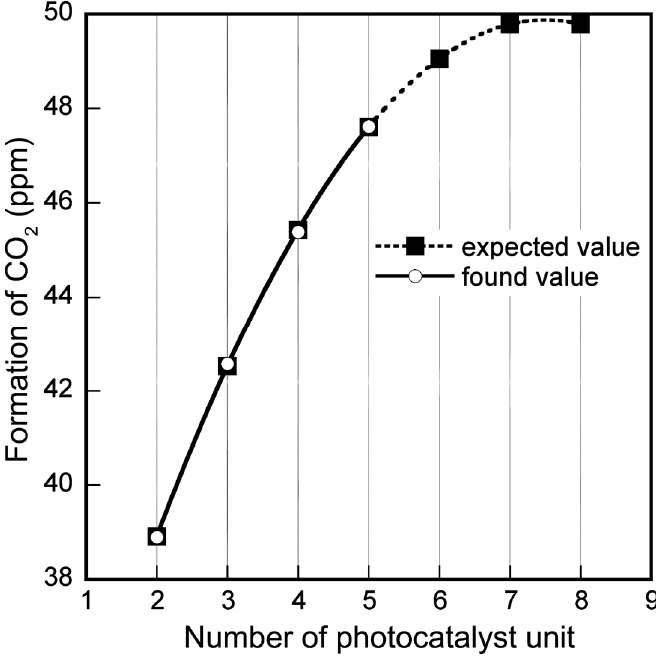
Figure 1. Plot of the amount of CO 2 formed as a function of the number of photocatalyst